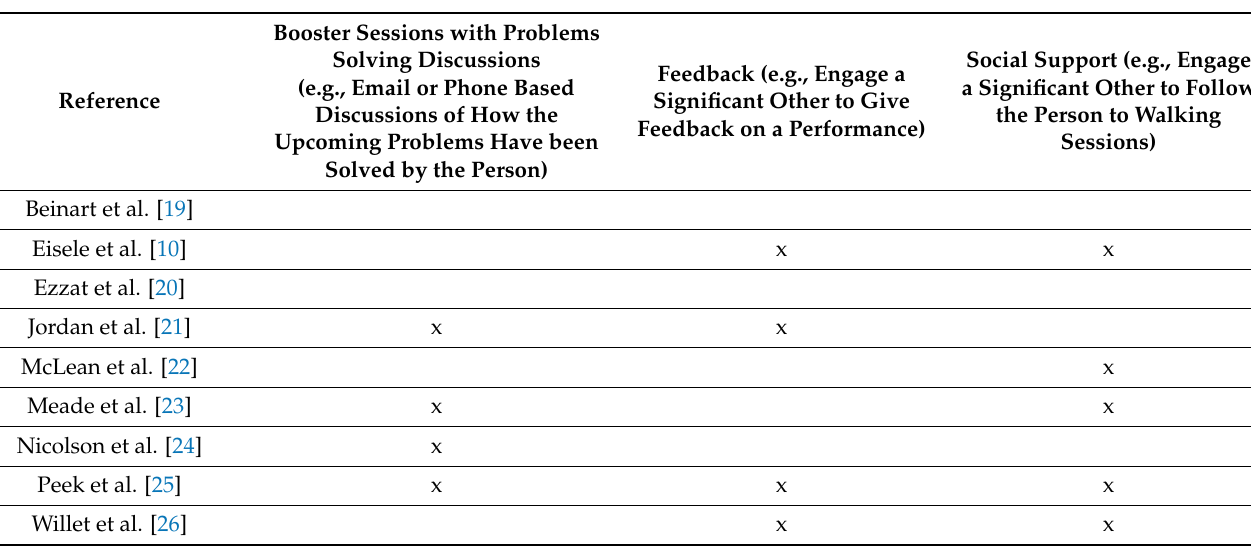
Table 5. Adherence to exercise behaviour components categorized according to the behavioural wheel provided by Michie et al. [42] regarding capability, motivation and opportunity. Opportunity: Opportunity consists of behaviour prompting factors external to the